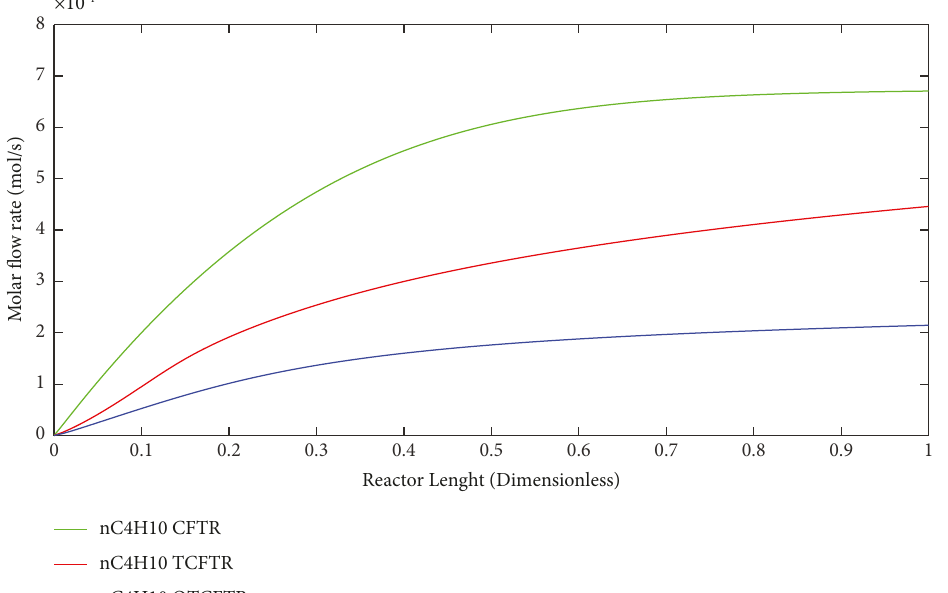
Figure 22: Comparison of the molar flow rate of normal butane in the exothermic part of the reactor for CFTR, TCFTR, and OTCFTR modes.